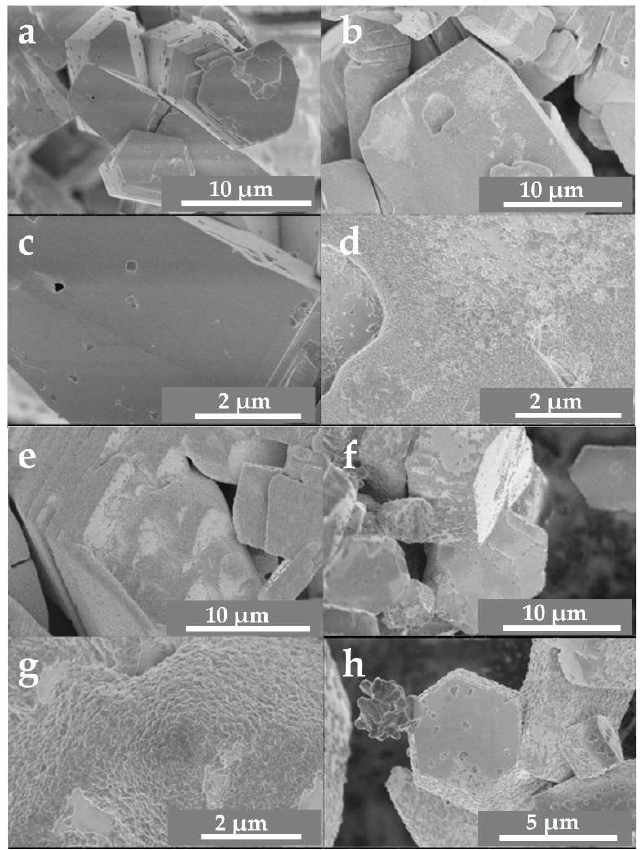
Figure 2. SEM images of Cu 3 Ta 7 O 19 crystallites before heating ( a , c ), and after heating in air to 350 °C for 60 min ( b , d ), 450 °C for 60 min ( e , g ), and 550 °C for 60 min ( f , h ). The ion diffusion and phase segregation of Cu(I) cations out of the structure, and their oxidation to CuO at the surfaces, can be represented by the following reaction: Cu 3 Ta 7 O 19 + x/2 O 2 → Cu (3 − x) Ta 7 O 19 + x CuO(surface). With the extrusion of Cu(I) cations from the structure and oxidation at the surfaces, an equal number of Cu sites within the bulk are also oxidized, as given by simple charge balancing: Cu I (3–2x) Cu II x Ta 7 O 19 . Temperature- dependent magnetic susceptibility measurements were taken on Cu 3 Ta 7 O 19 before and after heating in air from 250 ◦ C to 450 ◦ C. Listed in Table S3, the data were fitted to the Curie– Weiss expression (Cu(II) of S = 1 ) with the refined parameters. Upon heating in air, the 2 effective magnetic moment increased from ~0.179 µ B with no heating, to 0.216 µ B , 0.452 µ B , and 0.917 µ B after heating in air to 250 ◦ C, 350 ◦ C, and 450 ◦ C, respectively. Accounting for both the surface and bulk Cu(II) cations, these values correspond to %Cu(II) cations (i.e., x) in the bulk Cu (3 − x) Ta 7 O 19 , ranging from ~10.4% (x = 0.015) to 26.1% (x = 0.39) at 50 ◦ C, and to 53.0% (x = 0.8), respectively. This analysis is consistent with the refined Cu-site vacancy from the Rietveld analysis, with x = 0.34(1) after heating to 350 ◦ C in air, and supports the oxidation of Cu(I) to Cu(II) cations within the structure and at its surfaces according to the above reaction. Full oxidation eventually leads to CuTa 2 O 6 , as shown in the powder XRD data in Figure